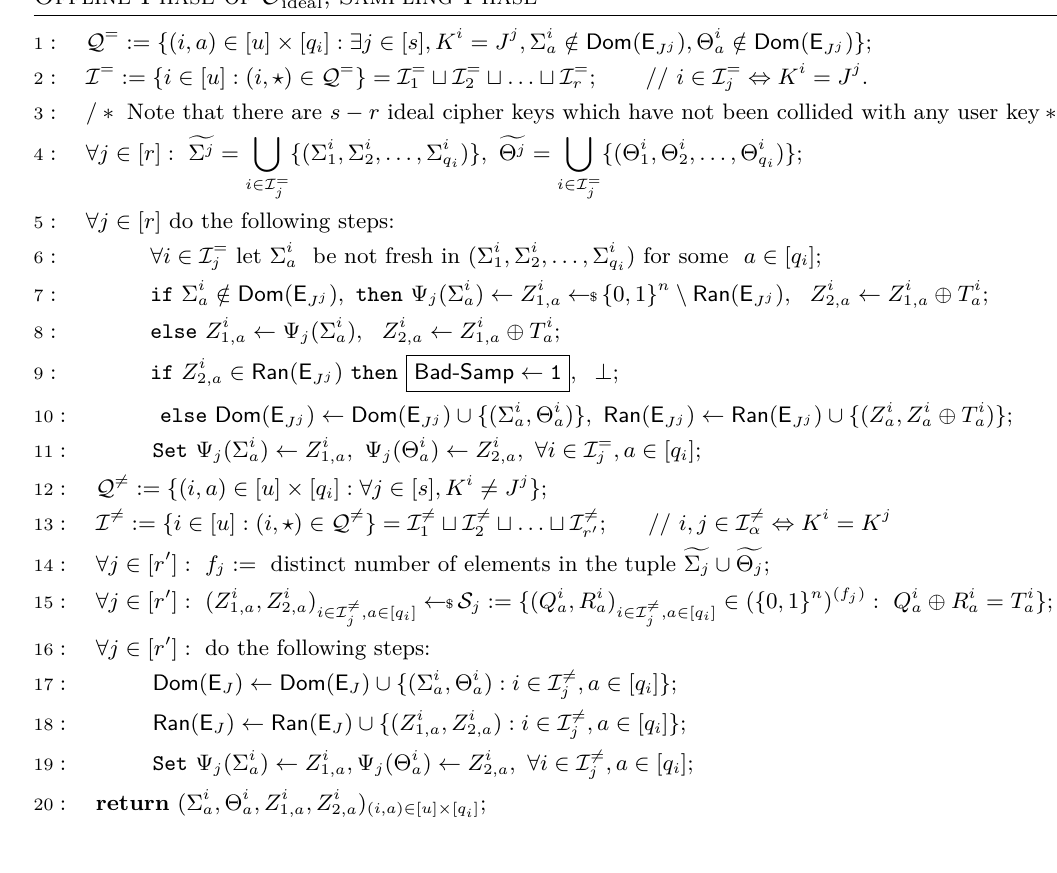
Figure 4.3: Offline Phase of the Ideal oracle $, where we sample the output of the hash